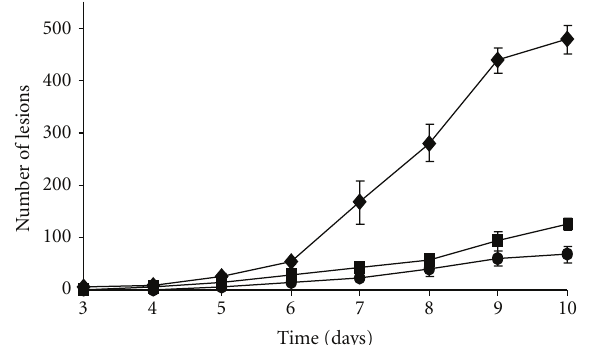
Figure 9: Disease severity of unwounded mango inoculated with the wild type. ( (cid:2) ), Cgpkac1 ( (cid:4) ), and Cgpkac2 ( (cid:2) ) mutants.